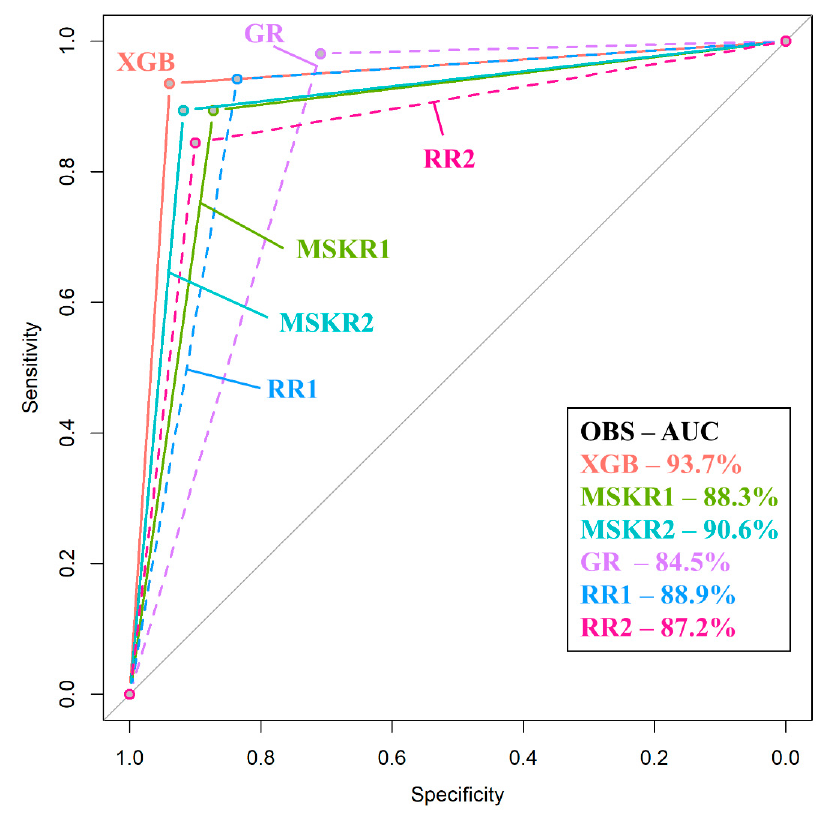
Figure 6. Comparison between receiver operating characteristic (ROC) curves of XGboost and expert readers. ROC curves of XGboost and musculoskeletal radiologists are plotted as solid lines whereas the ROC curves of residents and the general radiologist are plotted as dashed lines. XGboost (pink line) is shown to have the best performance, which was significantly higher than the performance of a general radiologist (GR—purple line). XGB: XGboost; MSKR: Musculoskeletal Radiologist; GR: General Radiologist; RR: Radiology Resident; OBS: Observer; AUC: Area Under the Curve.